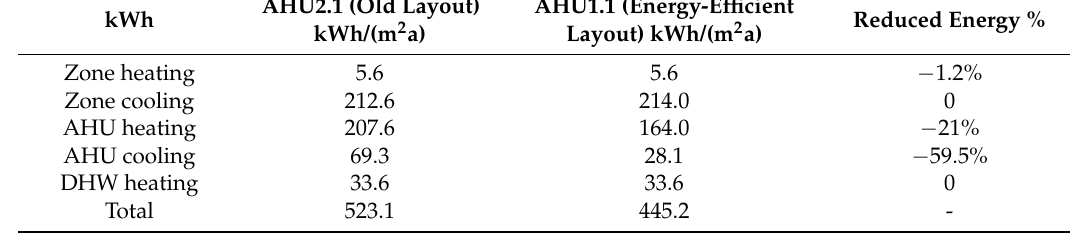
Table 3. The yearly energy consumption results of the simulation for AHU1.1 and AHU2.1.